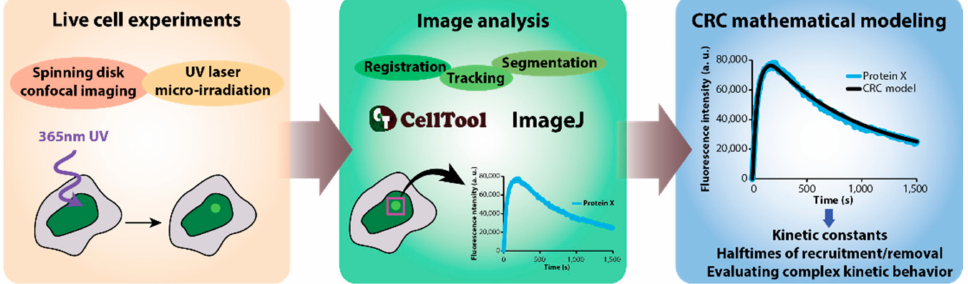
Figure 1. DNArepairK dataset